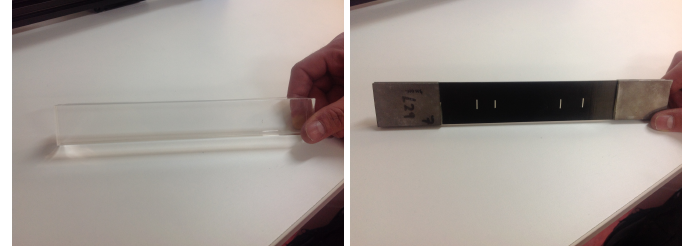
Figure 2. Polymethylmethacrylate material (PMMA) and carbon fibre reinforced polymer (CFRP)